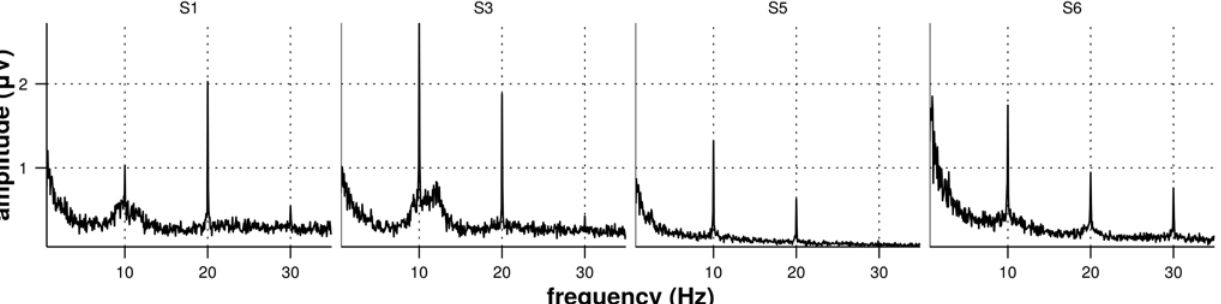
Fig 7. Amplitude spectrum of SSVEP responses. The figures represent the amplitude spectrum (average over 12 trials) of the EEG signals recorded at Oz for subjects S1, S3, S5 and S6 with a 10Hz stimulation frequency for the pure SSVEP